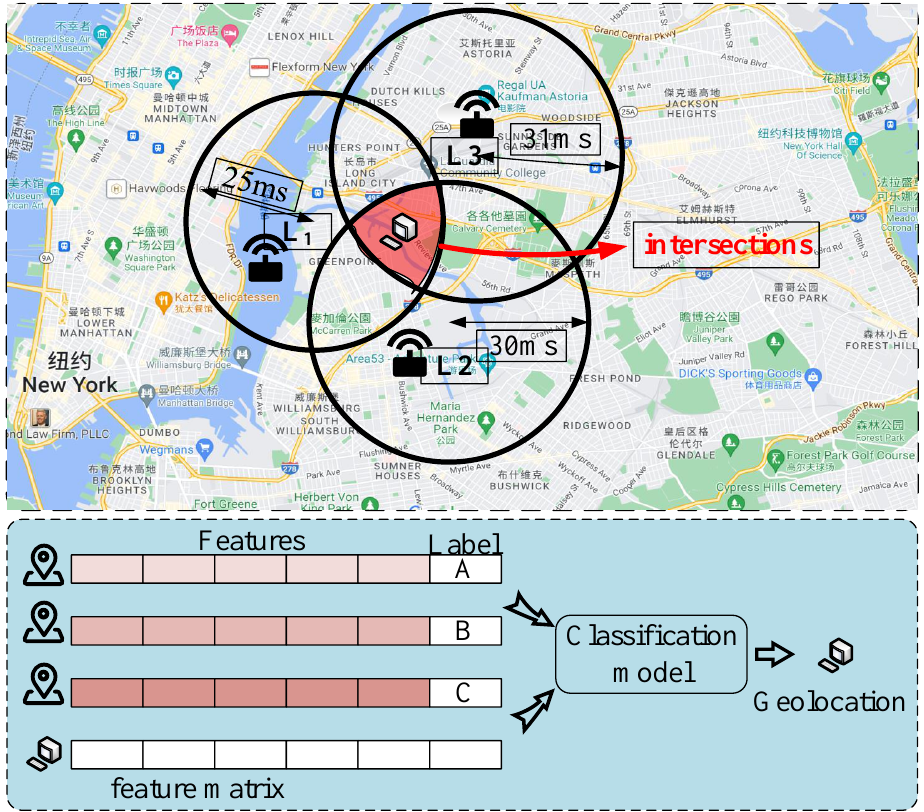
Figure 1. IP geolocation algorithm